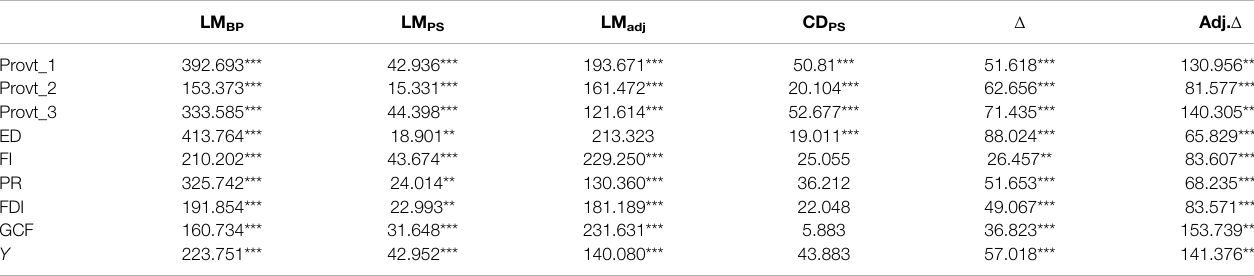
TABLE 5 | Results of CSD and heterogeneity